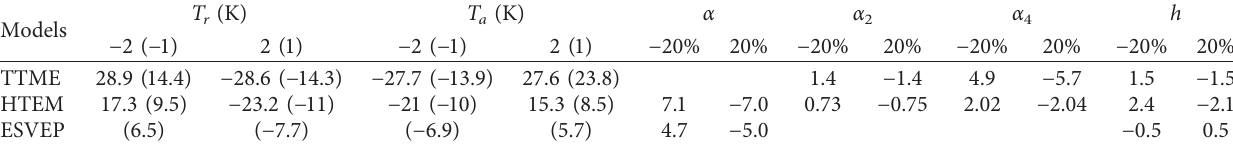
Table 6: Sensitivity S i (%) of LE estimates to each input in other two-source models based on trapezoidal space. Models